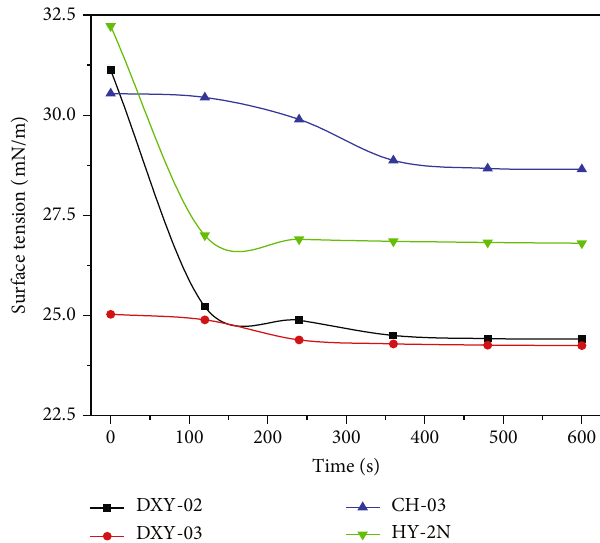
Figure 6: Relationship between surface tension and